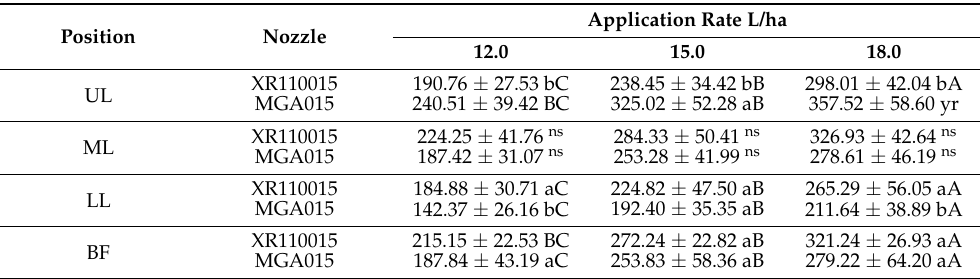
Table 7. Normality and analysis of variance (ANOVA) for the volumetric median diameter in the different layers of the plant and clusters of papaya